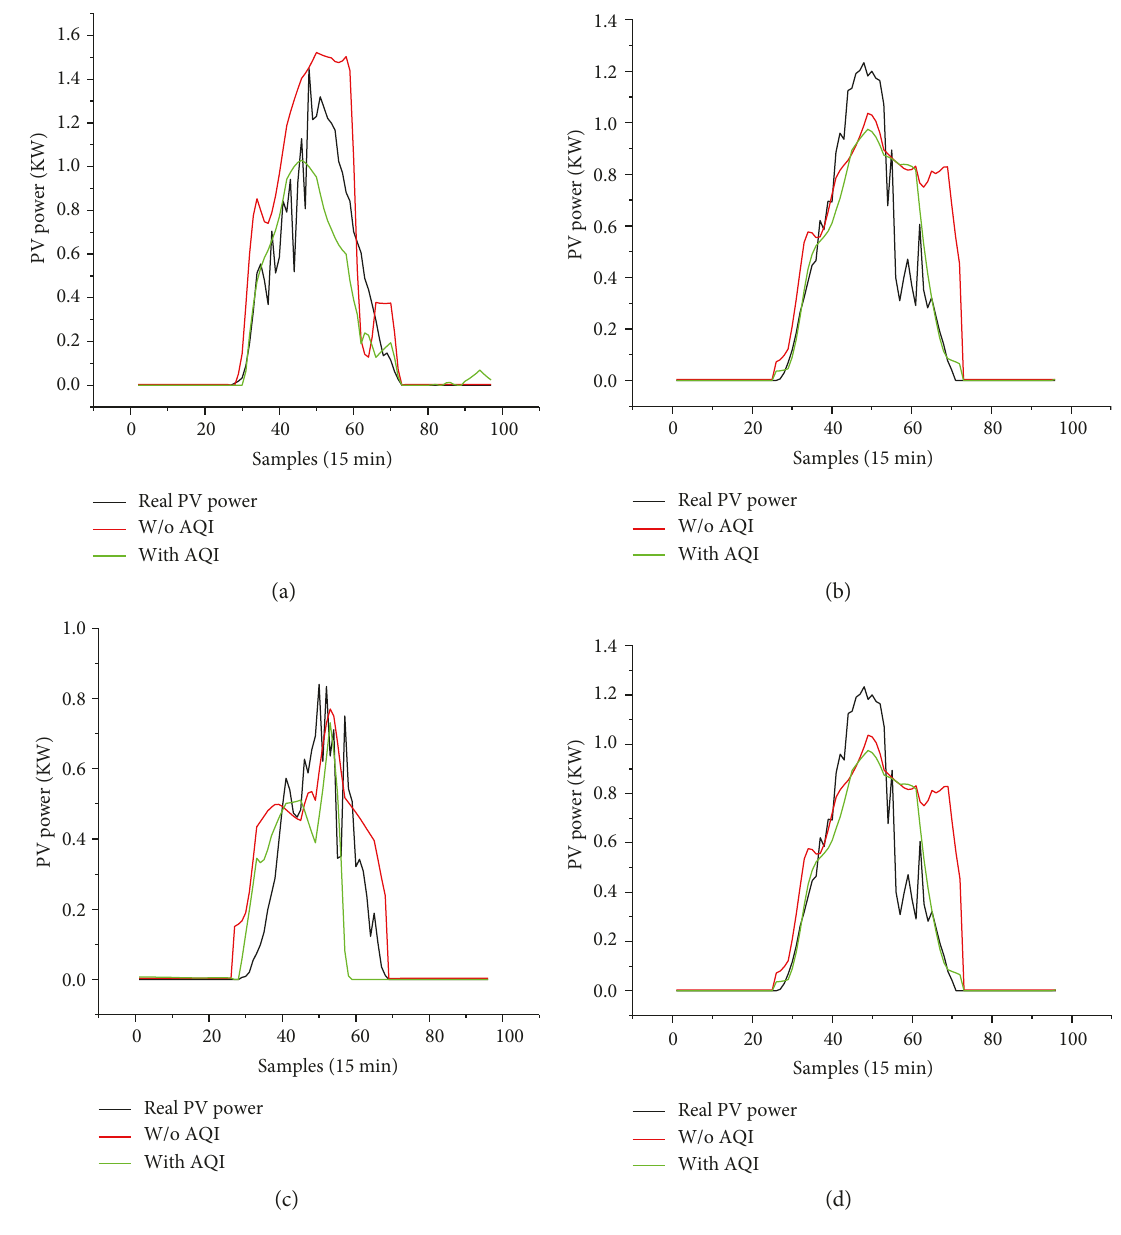
Figure 5: Haze weather forecasts ((a) day 1, (b) day 2, (c) day 3, and (d) day 4).